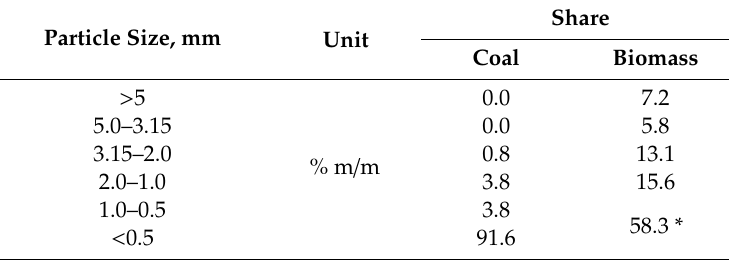
Table 2. Particle size distribution of raw materials